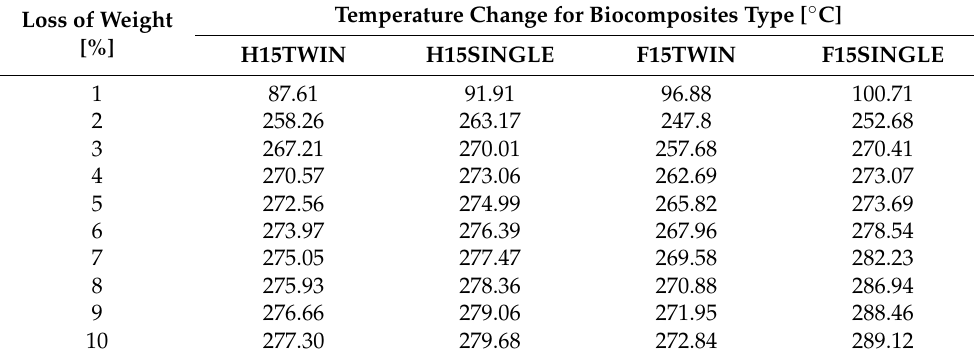
Table 8. The results of the static tensile test for biocomposites produced using single-screw and twin-screw extruders.